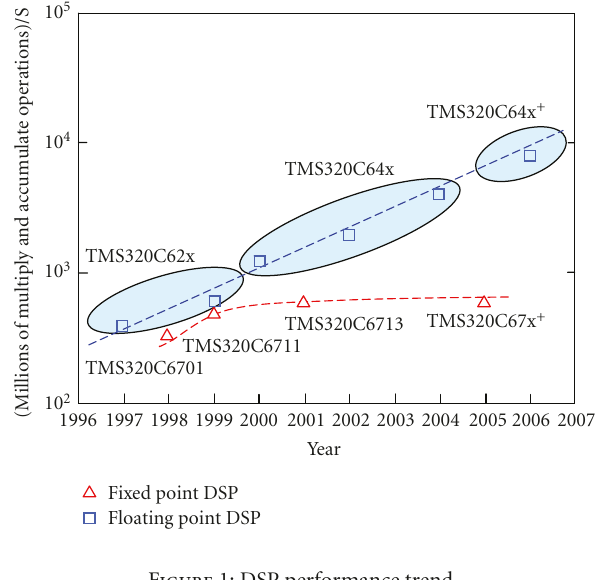
Figure 1: DSP performance trend.